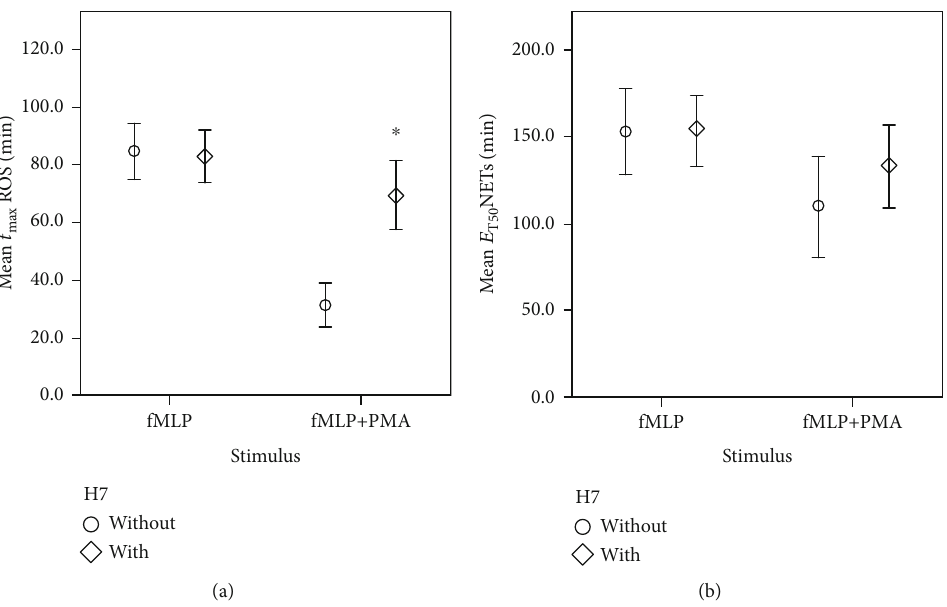
Figure 5: Delayed onset of oxidative activity and NET formation triggered by fMLP+PMA during H7 exposition. x -axis: cell groups stimulated using fMLP or fMLP and PMA; y -axis: (a) mean time of maximal ROS formation t max ROS in min; (b) mean time of half- NETs in min; ∗ signi fi cant ( P ≤ 0 : 001 ) compared to the control group without H7; error bars represent maximal NET formation E T50 standard deviation of